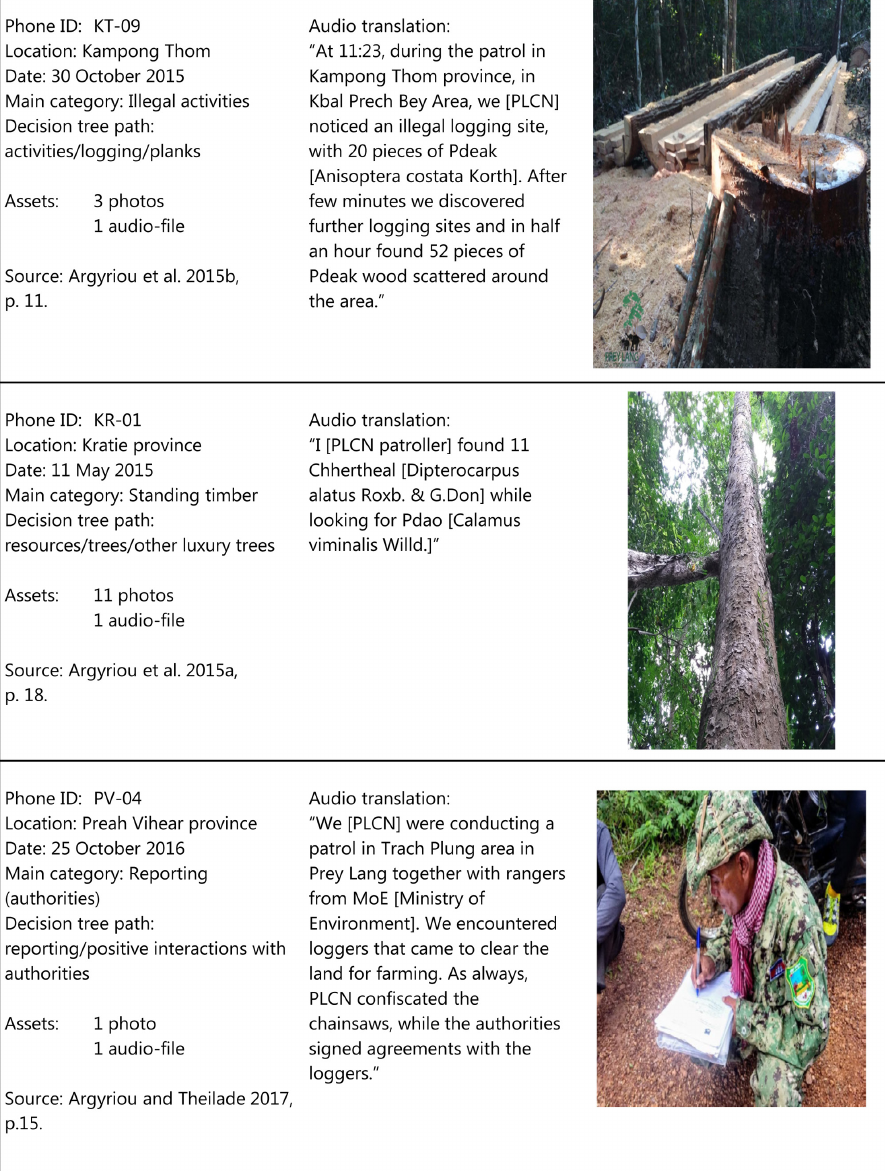
Figure 2: Three examples of validated data entries from the database about forest crimes and forest resources in Prey Lang, Cambodia, from each of the three main categories: Illegal activities, existing resources, and interactions with the